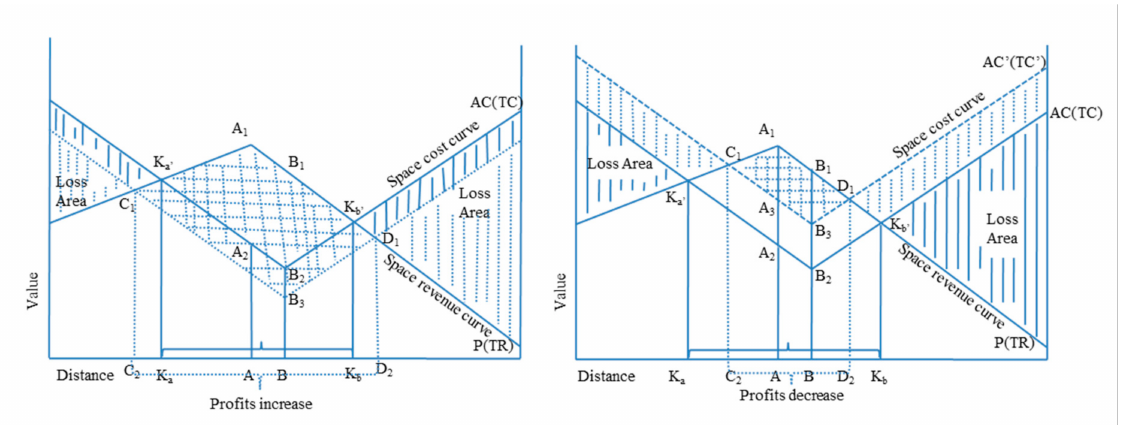
Figure 4. Changes in the model of the spatial boundary between cultivated land protection costs and